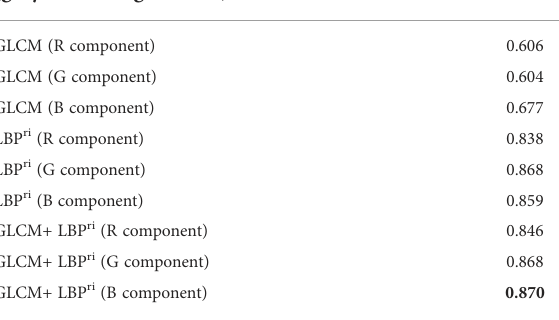
Figure 15. The accuracy comparison in the identi fi cation